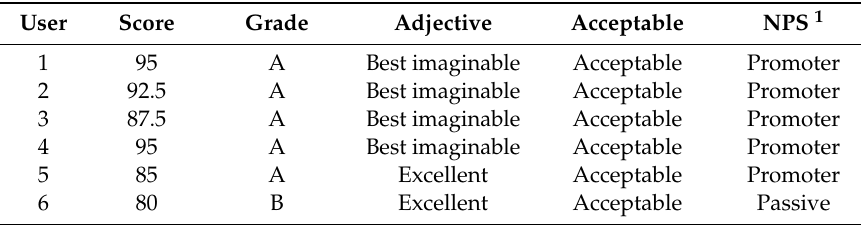
Table 5. SUS scores for sellers. Self-source,